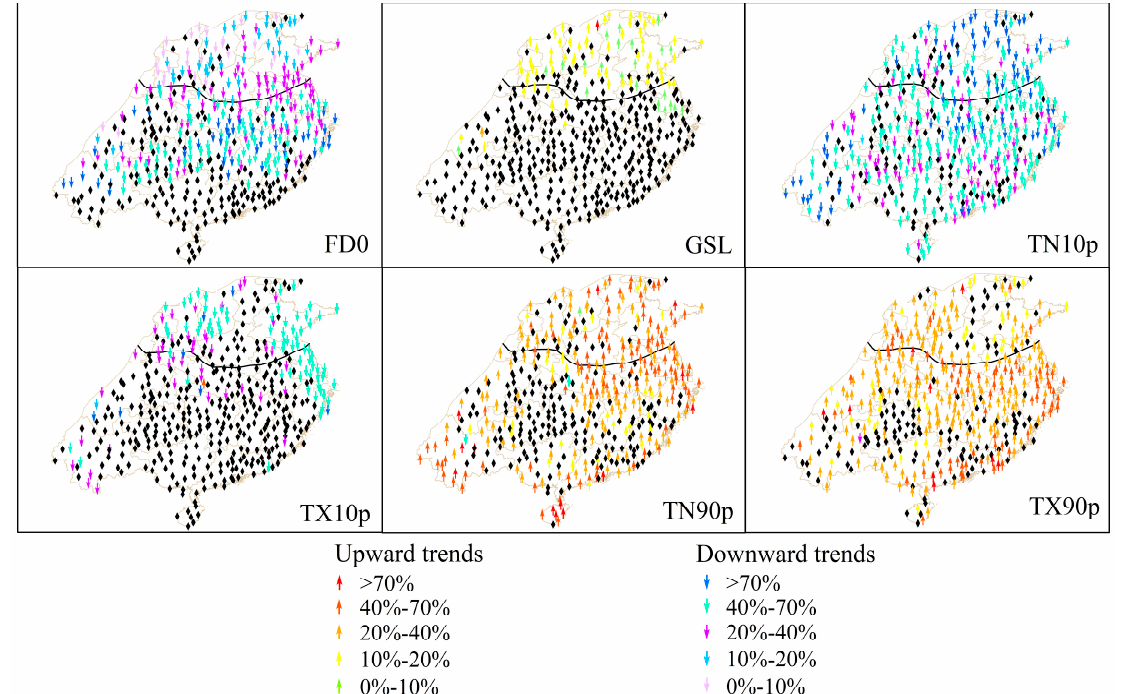
Figure 11. Spatial distributions of the trend magnitudes for the extreme temperature indices at a 30-year scale during the growth period of October 1961 to May 2016. The black rhombus represents insignificant trends, and the trend magnitude fails to pass the significance test of p = 0.05. The colored arrows indicate that the trend magnitude has passed the significance test of p = 0.05.